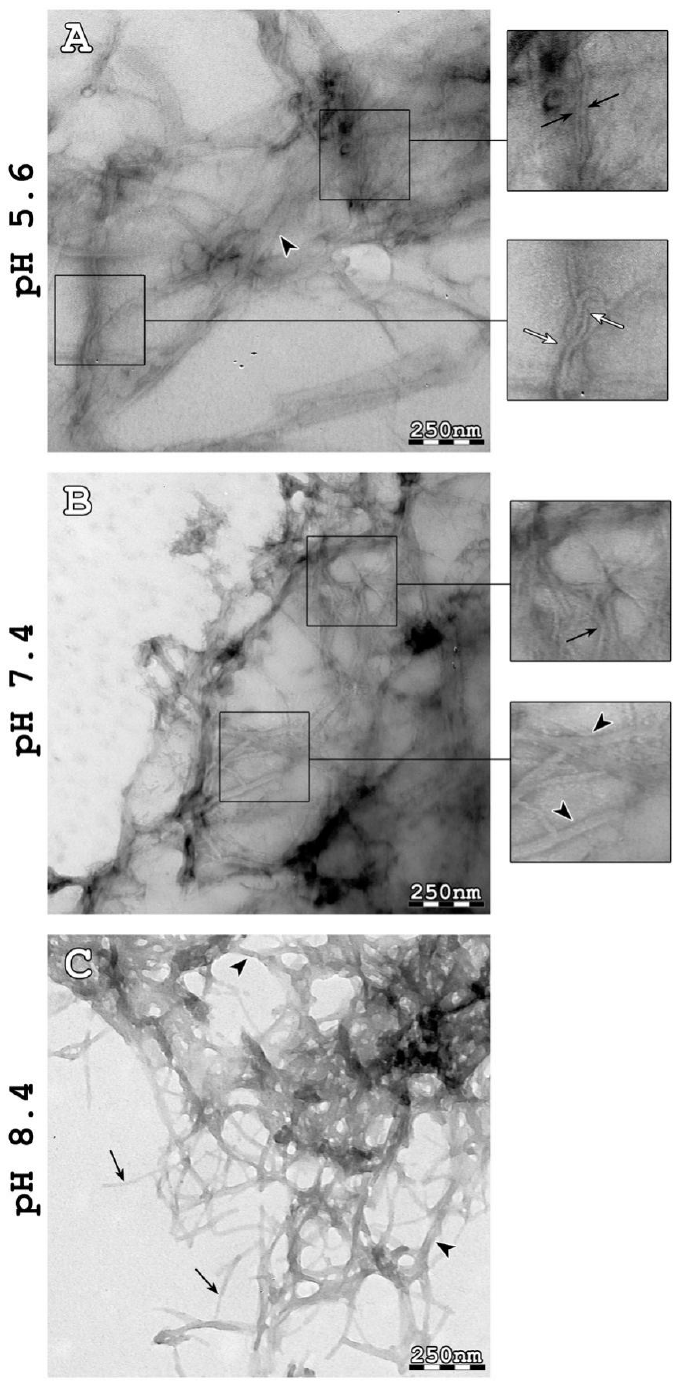
Figure 2. Transmission electron micrographs of amyloid-like fibrils derived from AtPNP-A 36–69 in three different pH conditions. ( A ) When incubated at pH 5.6 (MES buffer), the thinnest AtPNP-A 36–69 fibrils had a diameter of approximately 70 Å (black arrows). These fibrils interacted, forming either ribbon-like (black arrowheads) or twisted (white arrows) structures. ( B ) When incubated at pH 7.4 (HEPES buffer), AtPNP-A 36–69 formed amyloid fibrils, with a diameter of approximately 70 Å (black arrows). The fibrils formed ribbon-like structures with various widths (black arrowheads). ( C ) When AtPNP-A is incubated at pH 8.4 (Tris buffer), it formed straight, unbranched and of undefined length fibrils, with a diameter ranging from approximately 90 Å to 100 Å (black arrows). In this case, ribbon-like structures were also observed (black arrowheads). Bar 250 nm.